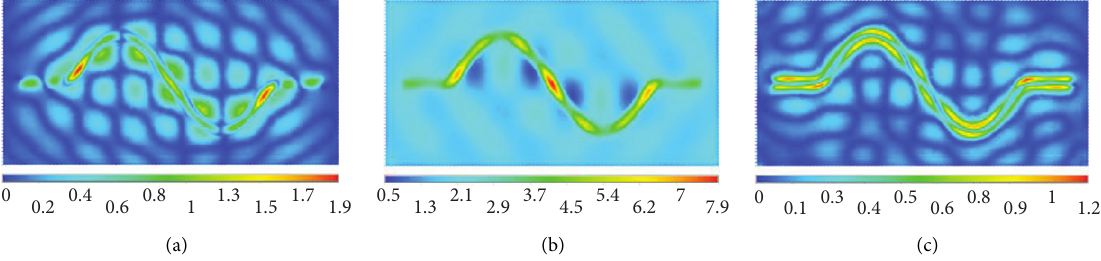
Figure 48: SH wave incident ( C